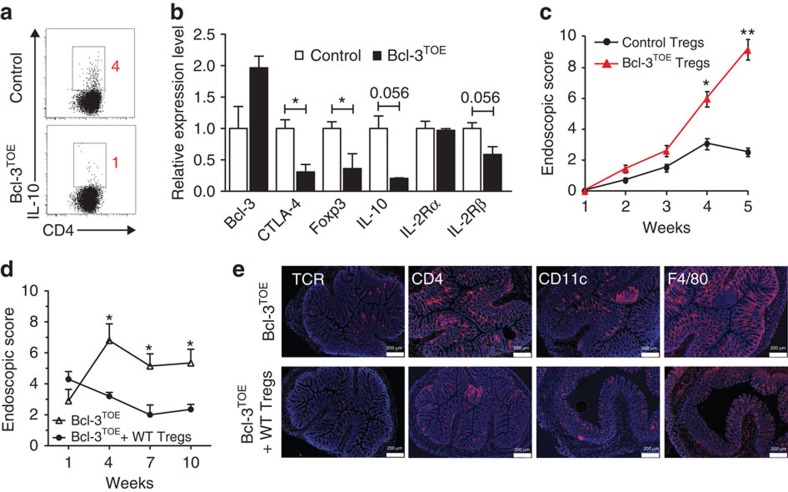
Bcl-3TOE Tregs display diminished suppressive capacity.(a) Flow cytometric analysis of MACS-purified CD4+CD25+ Treg cells of the indicated genotypes restimulated with PMA/Ionomycin and BrefeldinA for 4 h. Cells are gated on Foxp3+ and analysed for IL-10 expression. n=3. (b) Quantitative RT–PCR of MACS purified CD4+CD25+ Treg cells from the indicated mice (n=3). Shown are transcription counts of the indicated genes normalized to HPRT and littermate controls. *P<0.05 using unpaired Student's t-test. (c) CD4+CD25− T cells (5 × 105) isolated from control mice (n=3) by MACS were adoptively transferred into RAG1−/− mice alone or together with 5 × 105 CD4+CD25+ T cells isolated from control or Bcl-3TOE mice (n=5). RAG1−/− recipients were examined for signs of colitis by mini-endoscopy at the indicated time points. MEICS scores are shown. Mean±SEM. n=5 RAG1−/− recipient mice per group. *P<0.05 and **P<0.01 using unpaired Student's t-test. (d) CD4+CD25+ Treg cells (1 × 105) isolated from littermate controls (n=3) by MACS were adoptively transferred into 6 weeks old Bcl-3TOE mice (n=5) every 3 weeks. As controls Bcl-3TOE mice were injected with PBS (n=5). Bcl-3TOE recipients receiving either Tregs or PBS were examined for signs of colitis by mini-endoscopy at the indicated time points. MEICS scores are shown. Mean±s.e.m. *P<0.05 using unpaired Student's t-test. (e) Representative immunohistochemistry of colonic cryosections of the indicated genotypes stained for TCRγδ, CD4, CD11c and F4/80 (red). Nuclei were counterstained with Hoechst 3342 (blue). Scale bars, 200 μm. n=5 mice per group. Bcl-3OE mice without Cre were used as littermate controls.